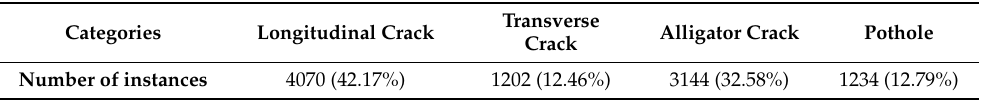
Figure 3. The types of pavement cracks: ( a ) longitudinal crack; ( b ) transverse crack; ( c ) alligator crack; ( d ) pothole. Table 3. The statistics for the self-building pavement crack instances.